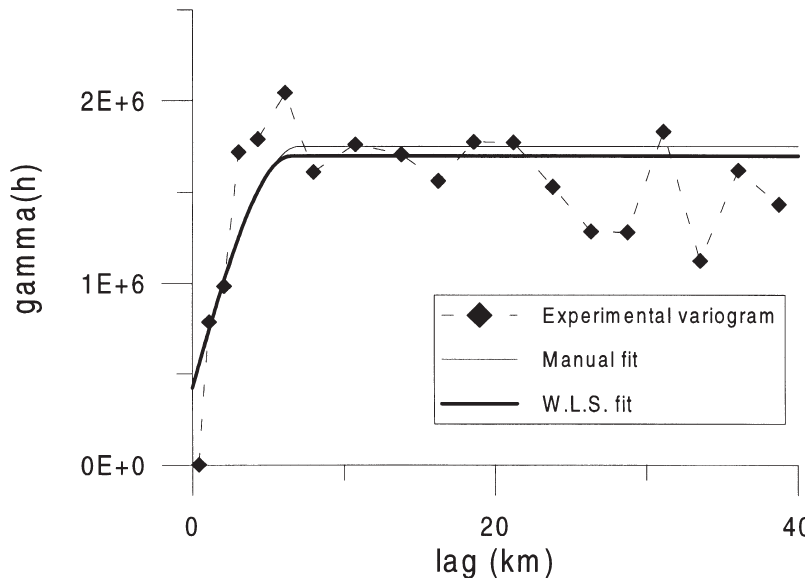
F IG . 5. – Comparison of a manual fit and an automated fit (weighted linear squares) to the experimental variogram in Fig. 4 (top). The variogram model is a spherical variogram (Appendix, section 2.2.1.a). The parameters of the manual fit are: Nugget= 4.50 x 10 5 ,